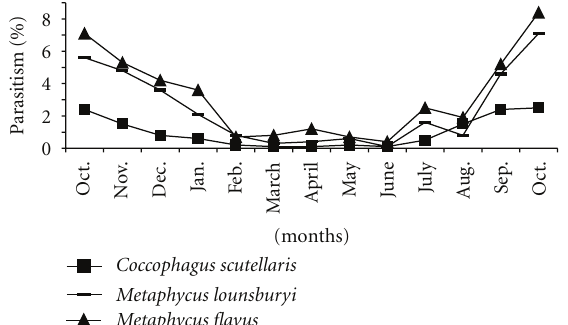
Figure 14: Percent parasitism of Coccophagus scutellaris and other associated parasitoids of Saissetia oleae on olive in Northern Coast governorate before releasing during